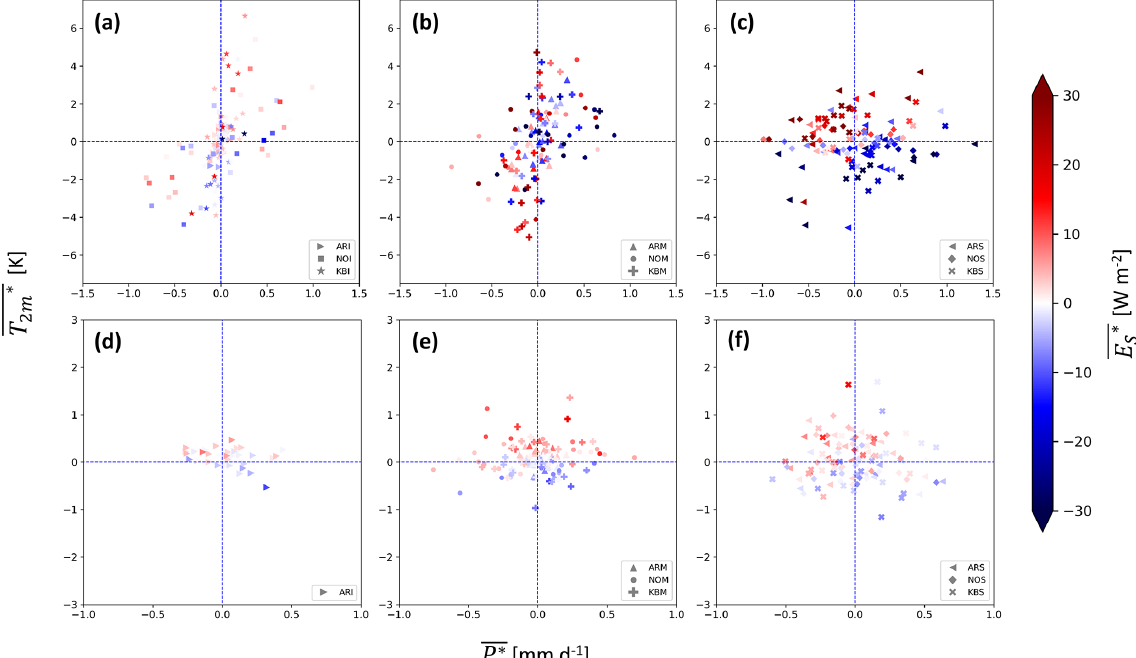
Figure 3. Seasonal-mean anomalies of P ( P ∗ ; mmd − 1 , along x axis), T 2m ( T 2m ∗ ; K, along y axis) and E S ( E S ∗ ; Wm − 2 , color) for 39 seasons in (a–c) DJF and (d–f) JJA for sub-regions with (a, d) SIC clim > 0.9, (b, e) 0.1 ≤ SIC clim ≤ 0.9 and (c, f) SIC clim < 0.1. Tables S1 and S2 in the Supplement show correlations and respective p values for the described relations between the different parameters in each sub-region.